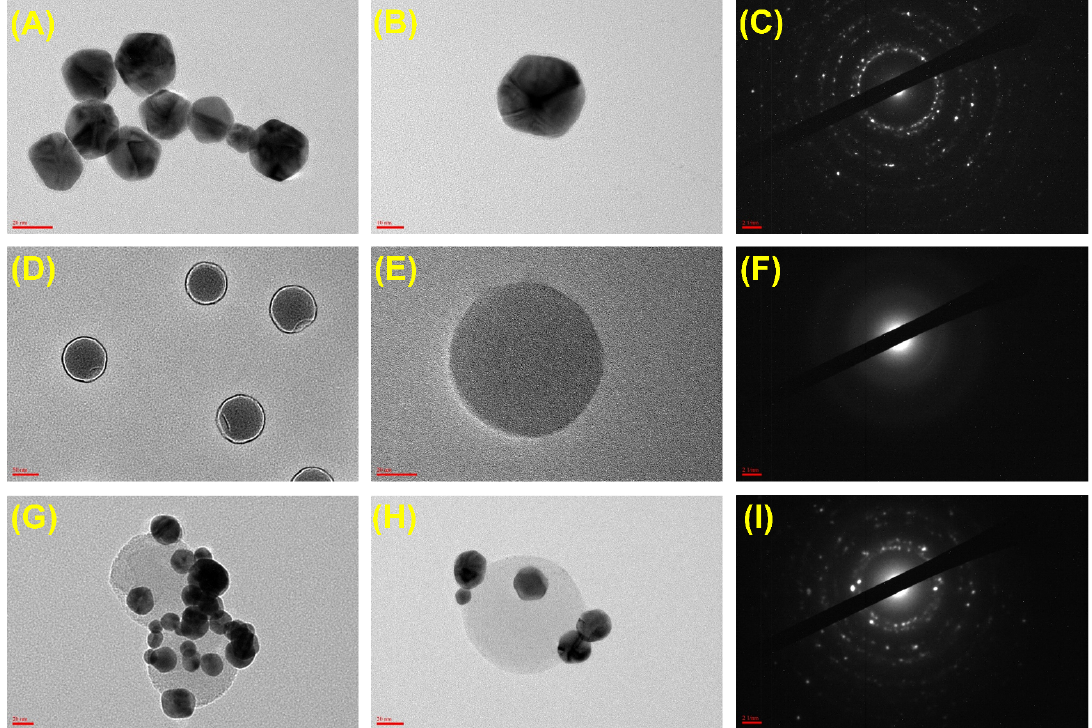
Figure 4. TEM with SAED pattern analysis ( A – C ) Cys AuNPs; ( D – F ) Commercial EuNPs; ( G – I ) Cys Au-EuNPs. Scale bar—( A , D , G ) 20 nm; ( B , E , H ) 10 nm; ( C , F , I ) 2 1/nm. According to the particle size distribution histogram (Figure 5A–C), the average sizes of the Cys AuNPs, EuNPs, and Cys Au-Eu Nps are estimated to be 29 ± 2.95nm, 100 ± 0.15nm, and 130 ± 0.66nm, respectively. The average diameters of the nanoparticles are almost the same according to the approximations obtained, using the Haiss and Bangs equations. The Haiss calculation for the particles before and after coating indicated Cys AuNps concentrations of 5.514 × 10 11 nps/mL (Cys AuNps) and 7.5 × 10 9 nps/mL (Cys Au- Eu Nps), respectively, while values of 1.803 × 10 13 nps/mL (EuNPs) and 5.45 × 10 3 nps/mL (Cys Au-Eu Nps) were obtained for the EuNps before and after coating, respectively, via the Bangs equation. Details of the calculations are given in Figure S2 (Supplementary Ma- terials) [34,35]. In addition, the functional group of those nanoparticles was analyzed by Fourier Transform Infrared spectroscopy (FTIR) and those results proved the formation of the ammonium and carboxyl groups on the surface of the EuNPs and Cys Au-Eu Nps (Figure S3, Supplementary Materials) [36]. Additionally, the surface charge of the Cys Au- Eu NPs was confirmed in negative charge, and it was stable in higher pH ranges. So, the Cys Au-EuNPs are highly suitable for further conjugation and the detailed results are pre- sented in the Supplementary Materials (Figures S4 and S5, Supplementary Materials).